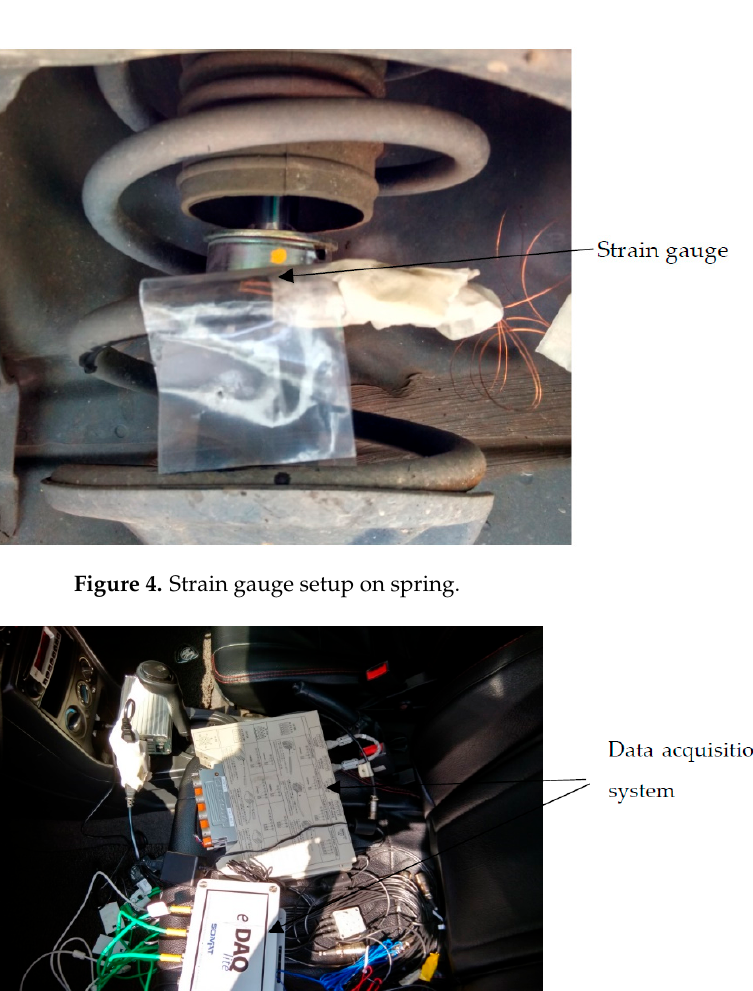
Figure 3. Accelerometer setup: ( a ) Top mount, ( b ) lower arm.